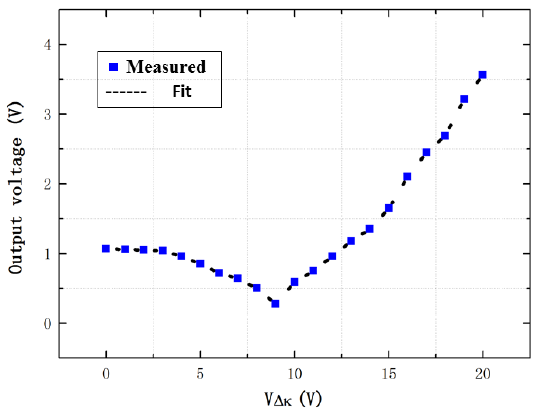
Figure 10. The measured vibration output of the differential sense capacitance in the anti-phase mode frequency.